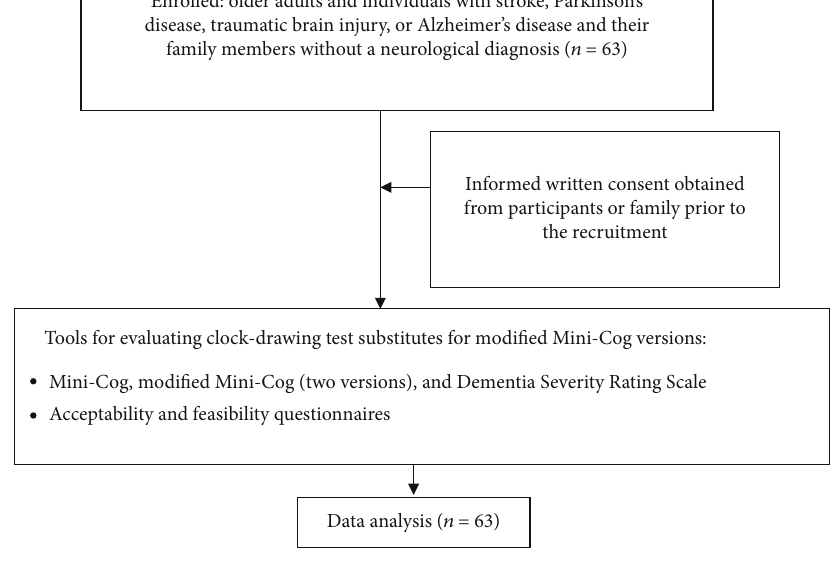
Figure 1: Procedural fl